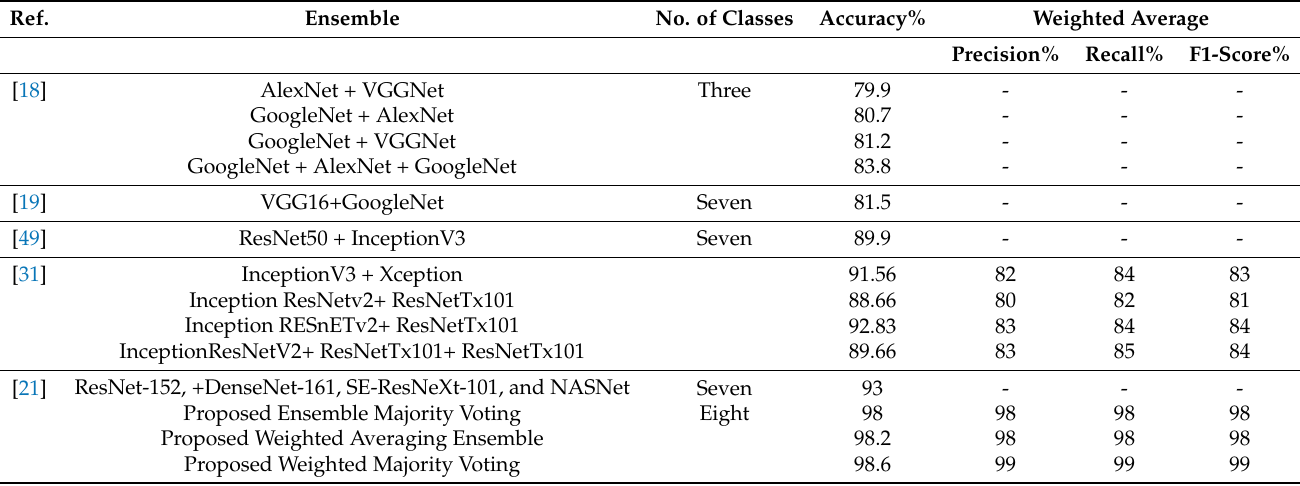
Table 5. Performance comparison with other deep learning-based ensemble models.